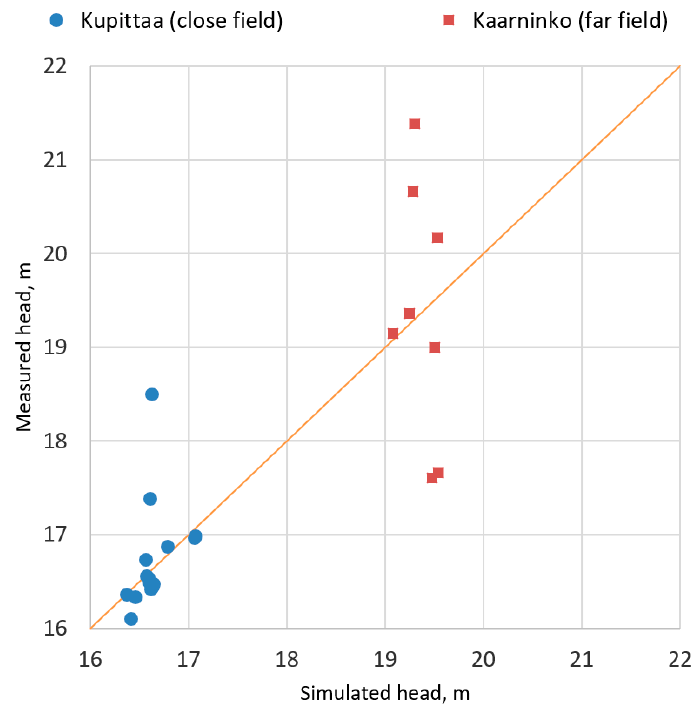
Figure 5. Groundwater model calibration.